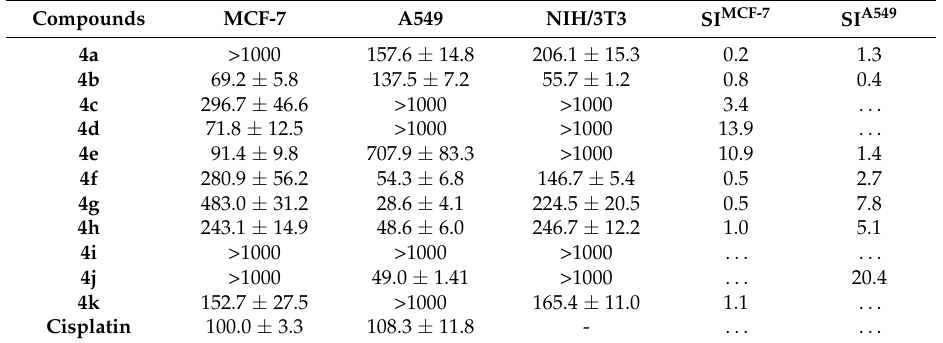
Table 2. IC 50 values (µM) of the compounds and SI values against MCF-7, A549 and NIH/3T3 cell lines. Compounds MCF-7 Table 2. IC µ M) of the compounds and SI values against MCF-7, A549 and NIH/3T3 cell lines. 50 values (